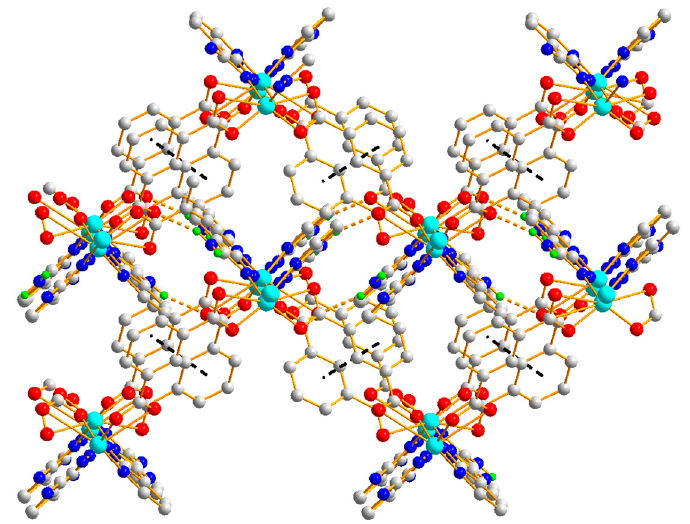
Figure 4. The 3D supramolecular network of Polymer 1 viewed down the a -axis.